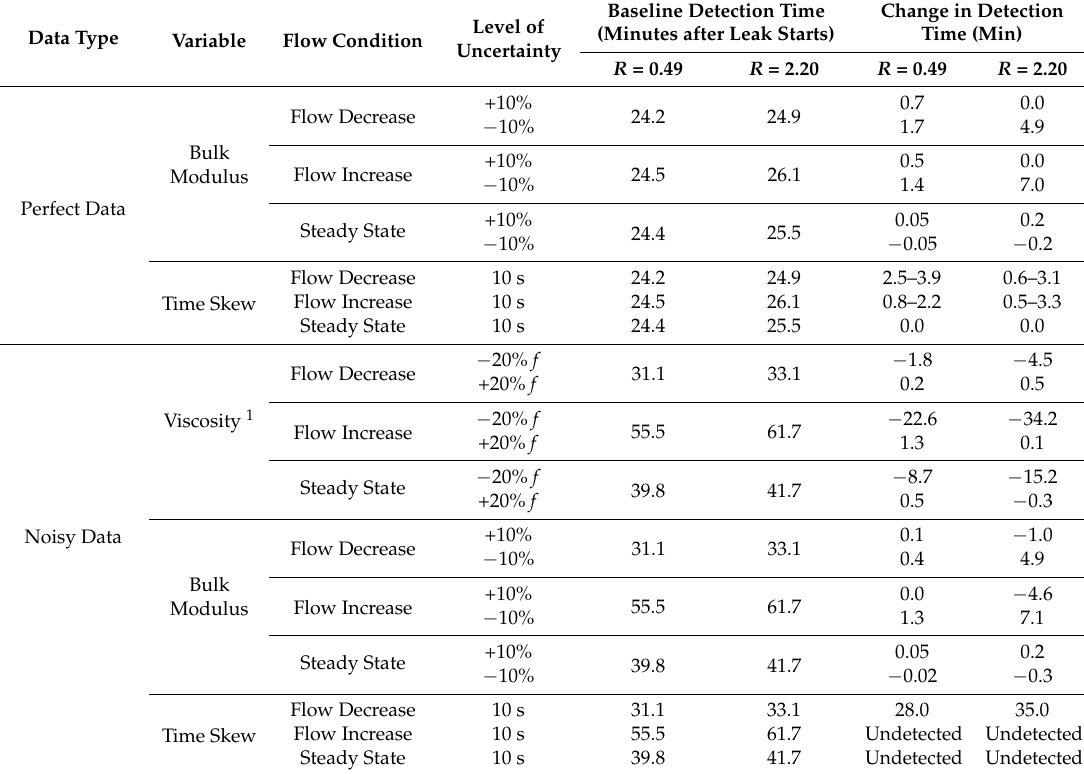
Table 5. Change in detection time due to uncertainties in systems with low and high R factors.